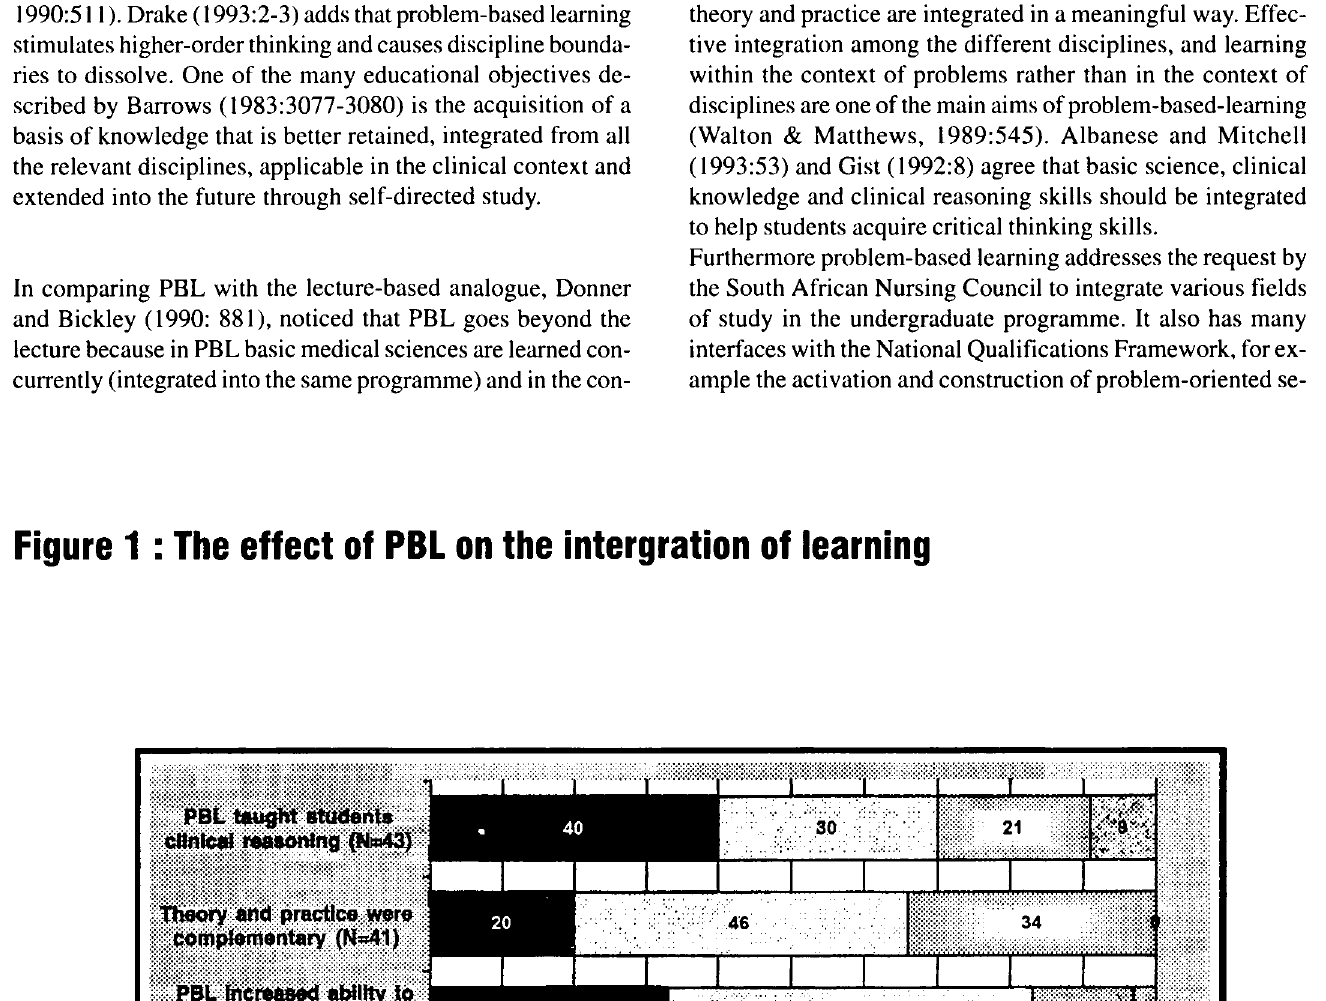
PBL teught Students citnleal reasoning